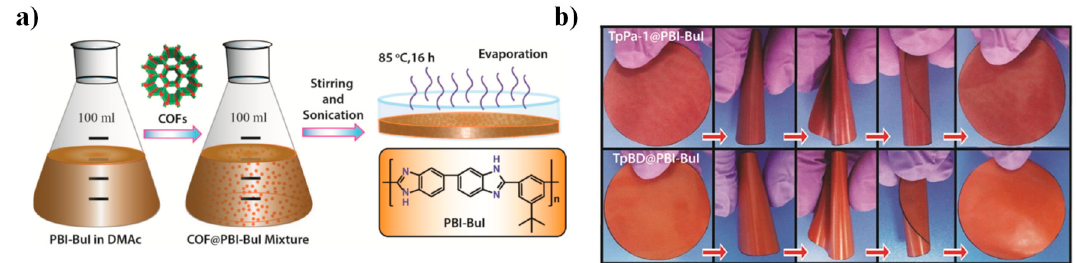
Figure 13. ( a ) Schematic illustration of the preparation of COF@PBI-BuI hybrid membranes. ( b ) Digital photos showing the flexibility of TpPa-1 and TpBD(50)@PBI-BuI hybrid membranes. Reprinted with